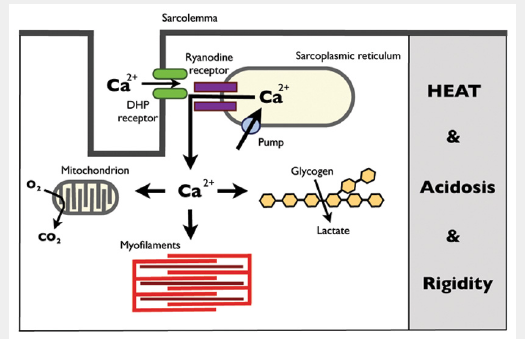
A schematic representation of the excitation-contraction coupling mechanism and the pathophysiological key elements of malignant hyperthermia (adapted from Lehmann-Horn et al. [36]). The muscle action potential is propagated along the sarcolemmal membrane into the transverse tubule, where the dihydropyridine receptors (DHP receptor) sense the action potential voltage change and open up. The conformational change of the opening DHP receptors then activates the ryanodine receptors, which release calcium from the sarcoplasmic reticulum. In malignant hyperthermia, an uncontrolled calcium release from the sarcoplasmic reticulum overwhelms the compensatory mechanisms within the skeletal muscle cell: increased muscle contractile activity and metabolic stimulation